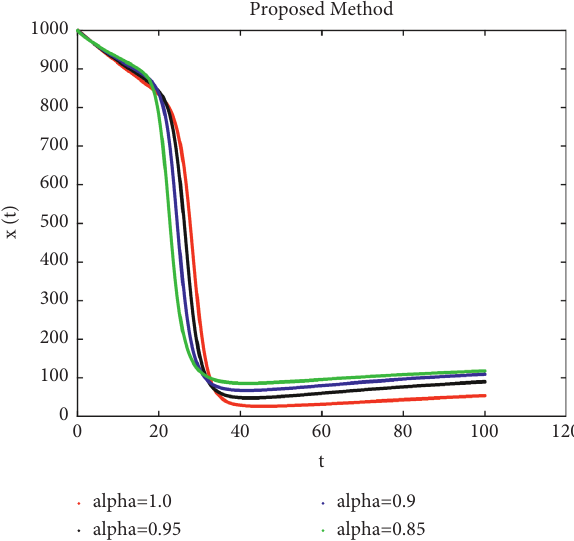
Figure 9: Dynamical behavior of free HIV virus particles at α � 1 and various fractal order � 0.85, 0.9, 0.95, 1 under power law kernel.